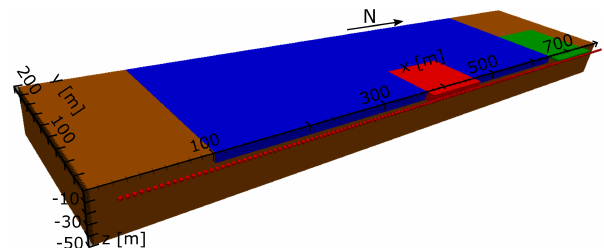
Figure 5. Sketch of the synthetic model used to generate synthetic data. It reflects a simplified version of the Äspö test site conditions. The red spheres mark electrode positions, the blue coloured areas simulate a low-resistive body, like sea water, and the brown parts mark highly resistive bodies, like bedrock.